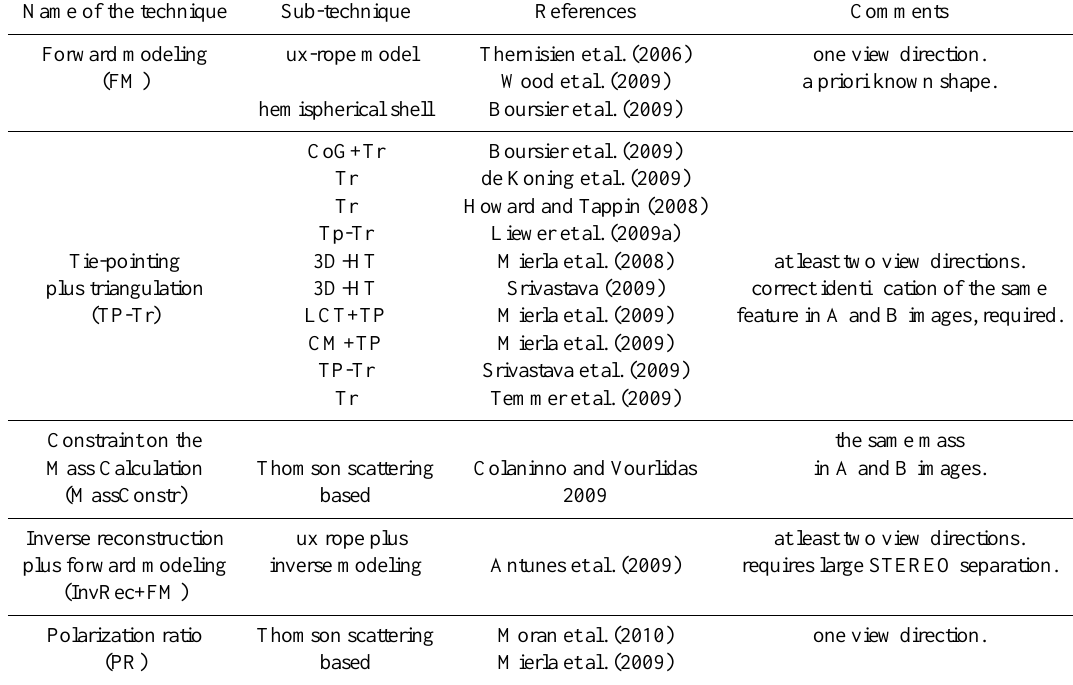
Table 1. Reconstruction techniques. See text for the abbreviations of sub-techniques.